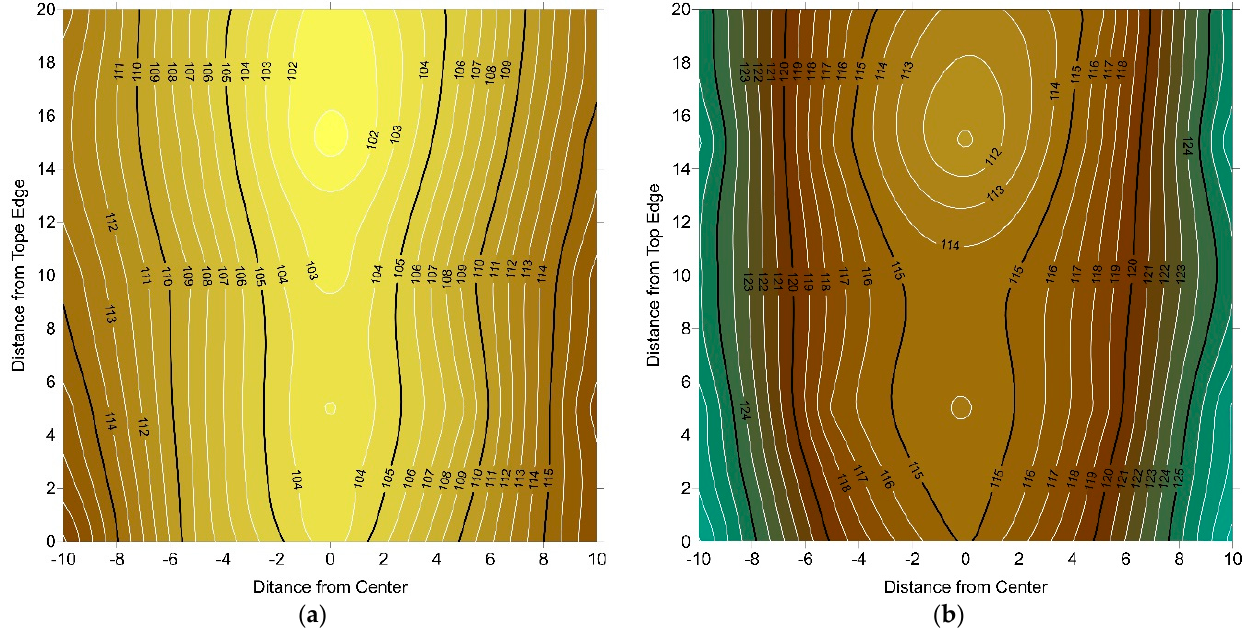
Figure 15. Color coded contour for the hardness values recorded on the LS of the Cu billets processed via ECAP through ( a ) 1-P and ( b ) 4-Bc at 200 °C.